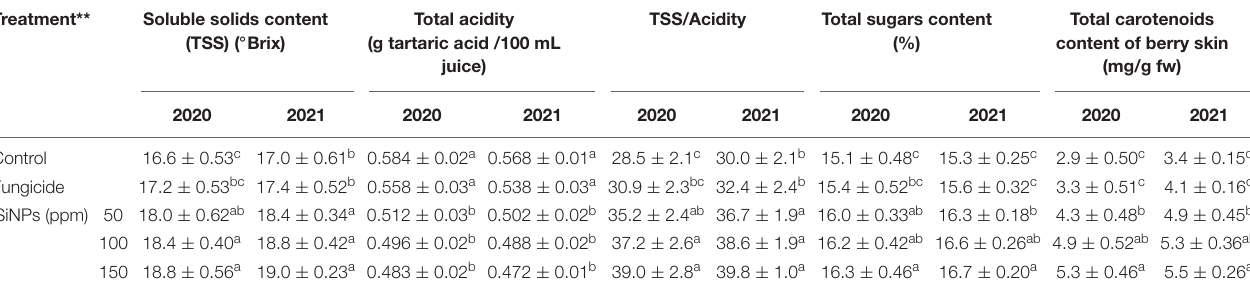
Frontiers in Plant Science |